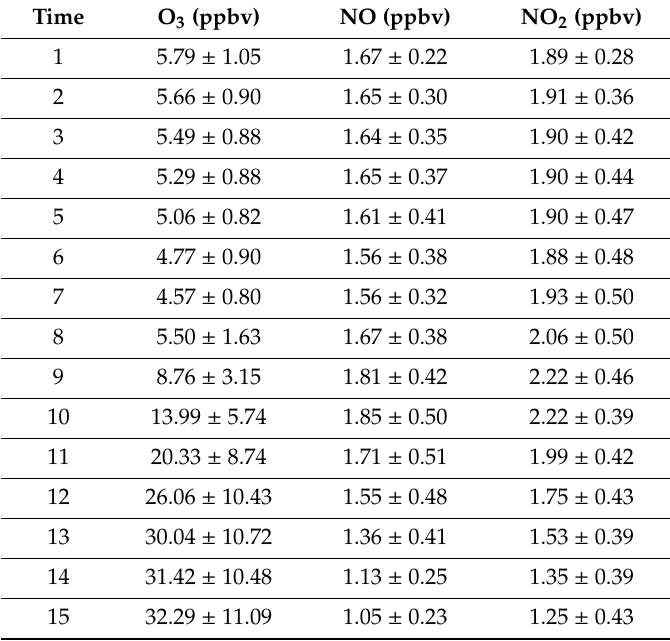
Table 3. The average hourly O 3 , NO, and NO 2 at